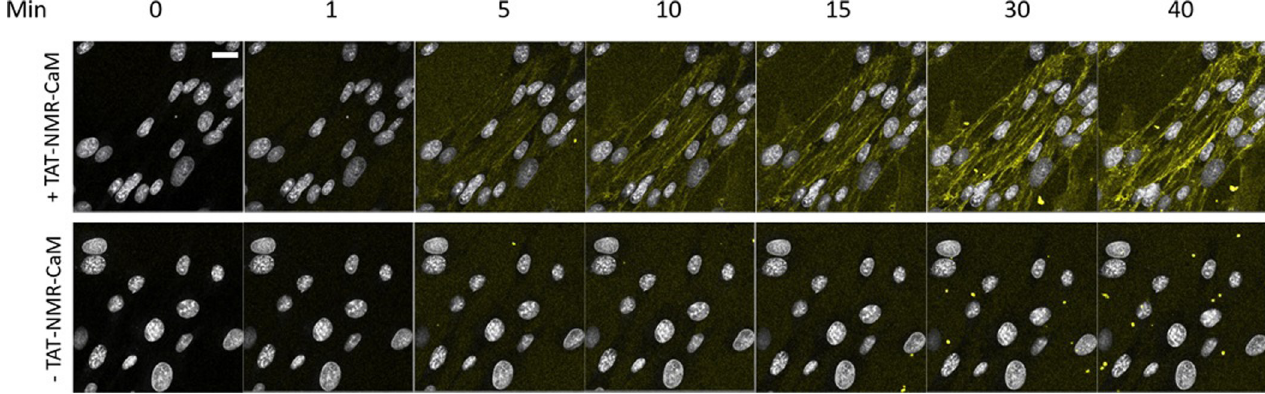
Fig 4. Gallery of images from real-time delivery of CBS-MBP to live cells. Top panel, TAT-NMR-CaM/CBS-MBP (400 nM each) were delivered; Bottom panel, CBS-MBP (400 nM) only was delivered. CBS-MBP was labelled (rendered as yellow) and cell nuclei (white) were stained prior to imaging with NucBlue. Cells were imaged with 40X objective at mid-point depth in cell. Scale bar = 20 μ m. CBS-MBP was present in the media throughout this imaging process. Movies available in (S4–S7 Figs).